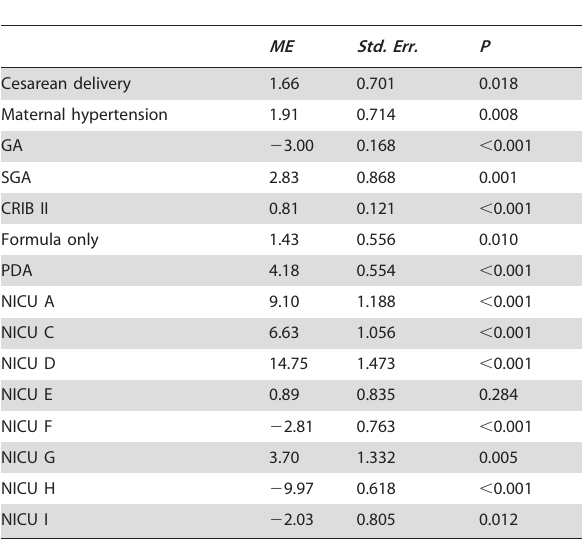
Table 3. Marginal effects (differences in days) in predicted median time to full enteral feeding achievement for FEF predictors.